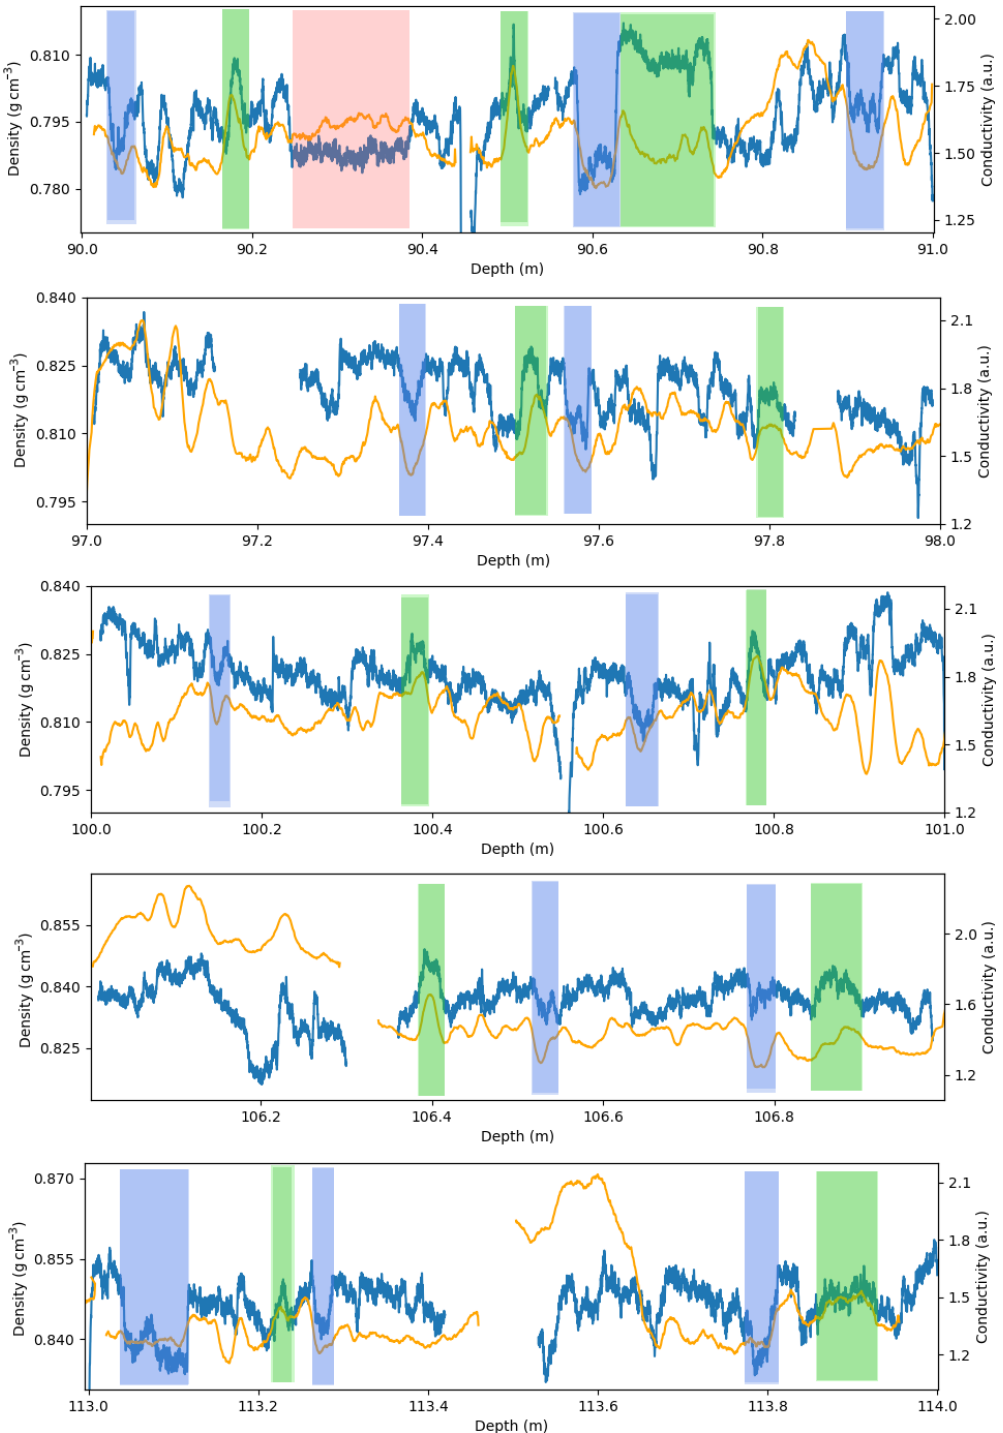
Figure 7. Density (blue curve) and liquid conductivity (orange curve) variations in five 1m long core sections. The green and blue portions respectively highlight some sections where density and liquid conductivity show a simultaneous increase or decrease. The pink portion highlights a section where the decrease in density is not matched by a decrease in liquid